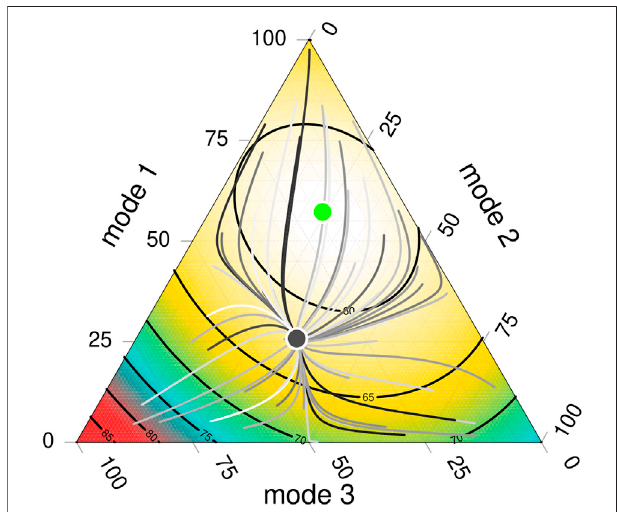
FIGURE 3 | The mean commuting time function μ x gives the weighted time for each transport mode, considering the number of users that experiencesuchcommutingtimes.Withlinearcosts,thefunctionisasecond- degree polynomial, with some minimum mean cost which might be inside X N .Threetransportmodeoptionsaresimultaneouslyplotted.Theblack curves marked with numbers 60, 65, 70, and so on, correspond to a contour curve of the commuting time function, where the average commuting times are 60 min, 65 min, etc. The attractor node is the dark disc, and the optimum distribution is the green